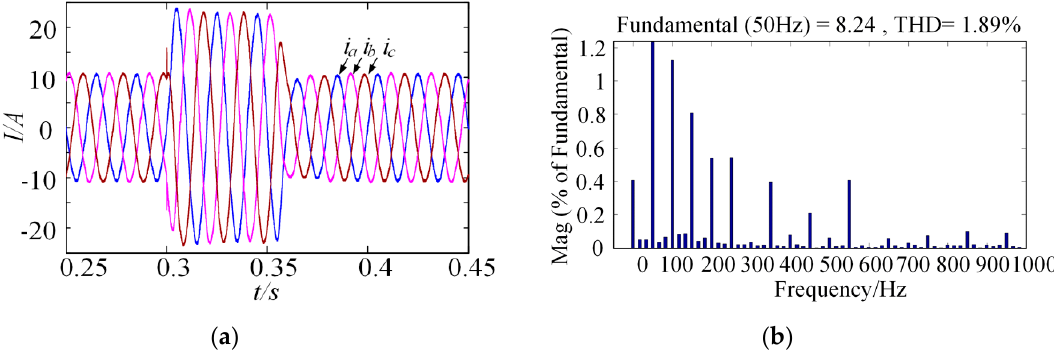
Figure 13. After compensation: ( a ) Grid current; ( b ) Current THD.